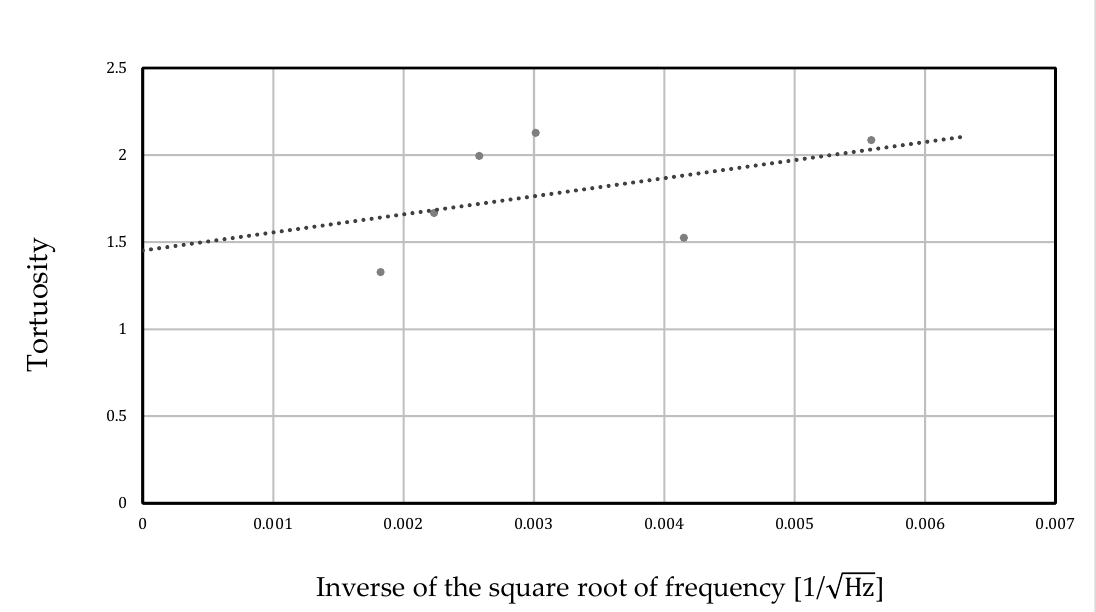
Table 1. Result of the tortuosity measurement.